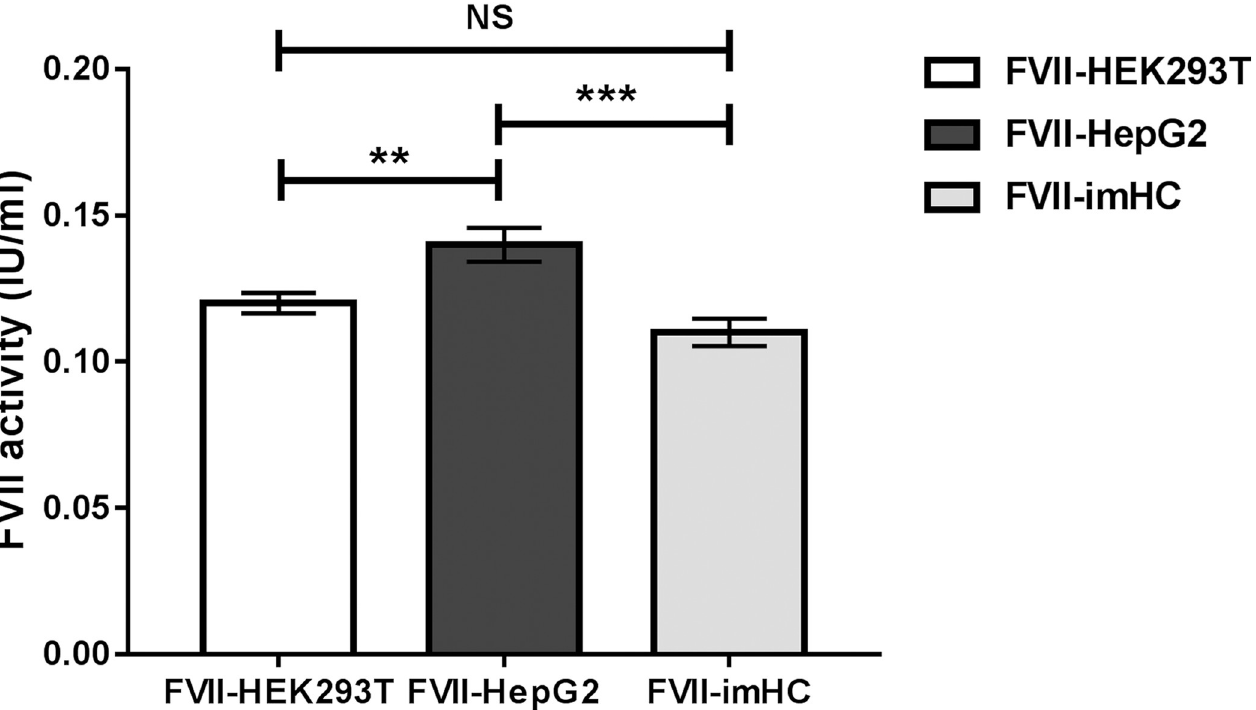
Fig 3. FVII coagulant activity from each cell line determined by chromogenic assay. FVII coagulant activity was determined by the chromogenic assay (two- step FXa generation). Equivalent molar concentrations (0.01 nM) of FVII from each cell line were used to evaluate coagulant activity, which was reported as IU/mL (mean ± SEM). The coagulant activity between two cell lines was compared using Student’s t-test. �� p < 0.05. NS; not significant.